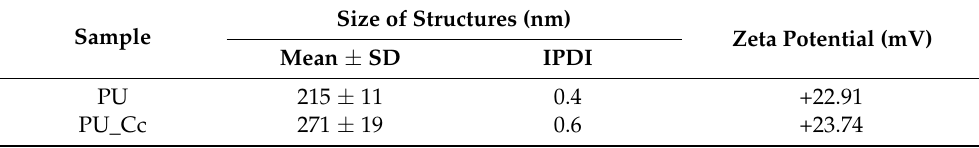
Table 2. Experimental values of the Zetasizer characterization.